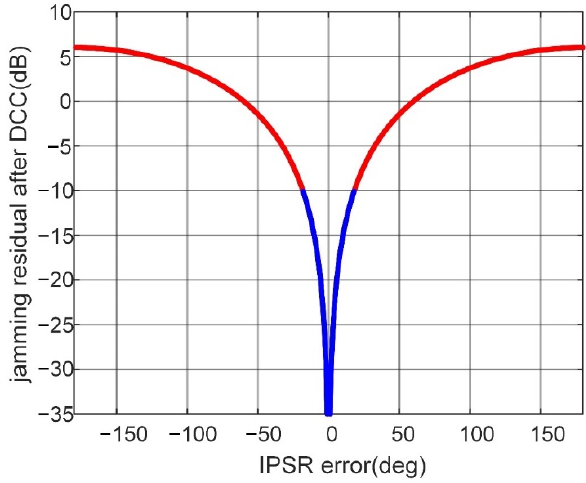
Figure 1. Jamming residual with IPSR error.